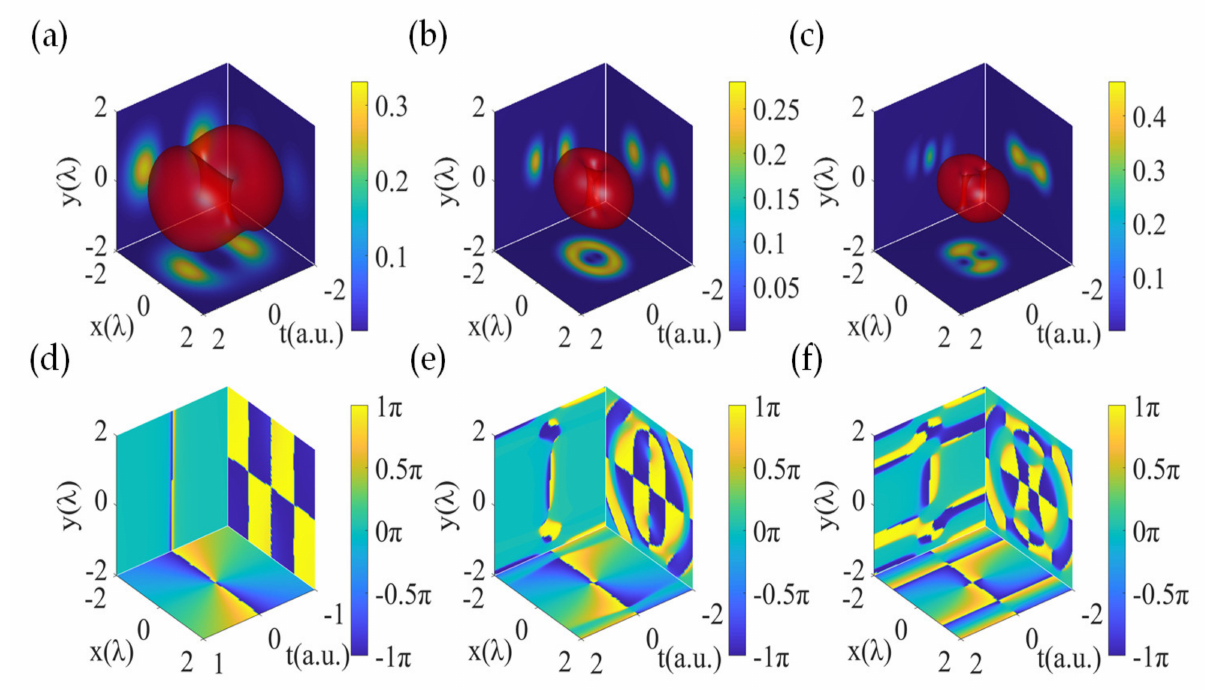
Figure 3. The intensity and phase distributions of the x-polarized components of the focused STOVs under different incident spatial waist radii. ( a – c ) The intensity distributions of the x-polarized components of the focused STOVs corresponding to incident spatial waist radii of 0.3, 0.5, and 0.7, respectively. ( d – f ) The phase distributions corresponding to the three cases, respectively. The isosurfaces are depicted at 5% of the maximum intensity in each